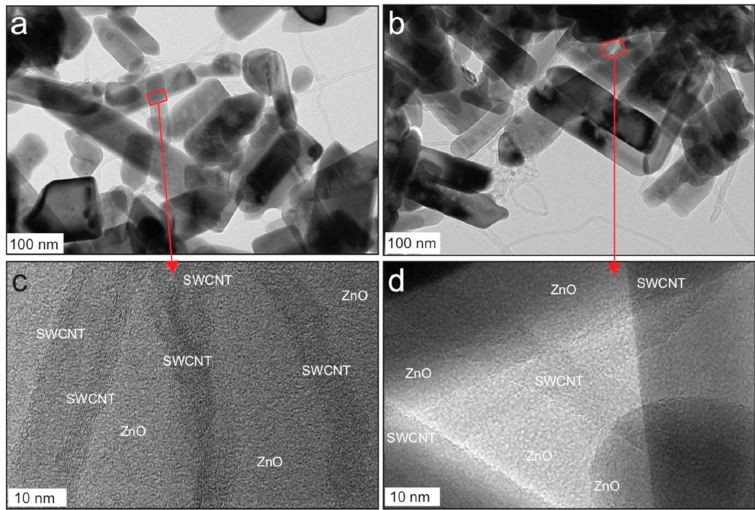
Figure 5. ( a , b ) Low-magnification HR-TEM images of the ZnO–SWCNT nanocomposite, and ( c , d ) high-resolution images corresponding to the region marked in images ( a , b ), respectively.